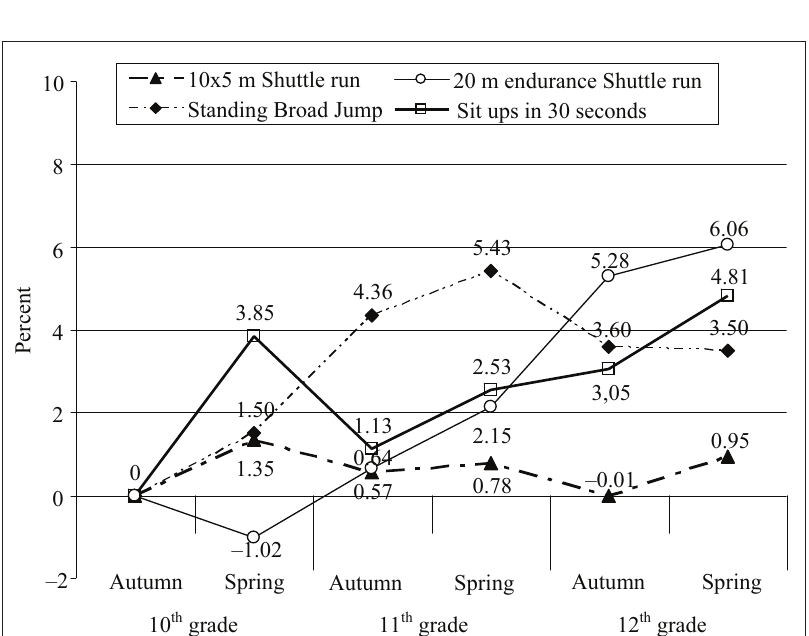
Figure 3. Changes in Sit ups in 30 seconds test results